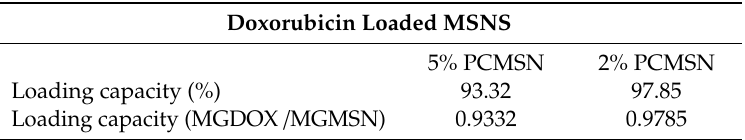
Table 3. Loading Capacity of PCMSNs with